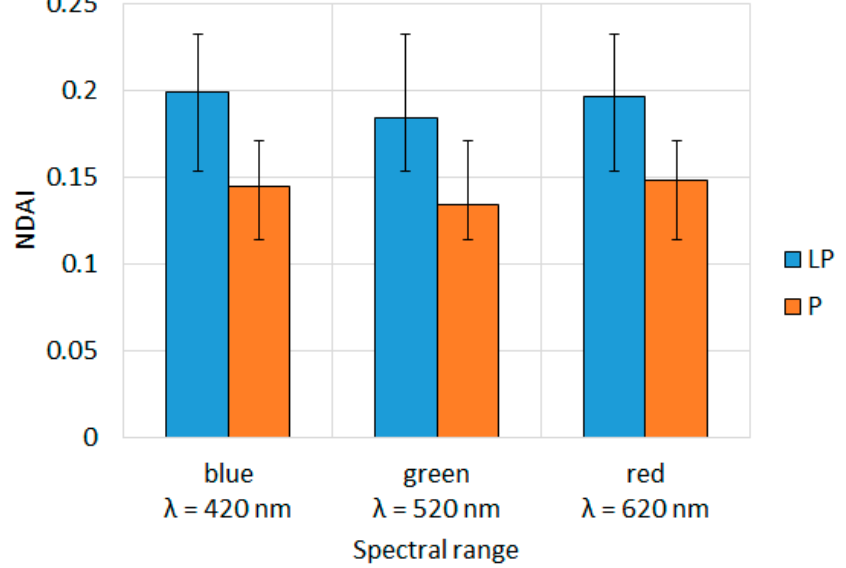
Figure 3. NDAI VIS spectral indices.